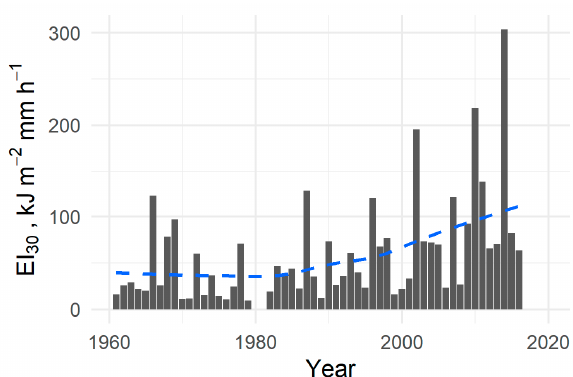
Figure 11. Annual variability of EI 30 between April and October at Müncheberg (near station 3376), smoothed with a local weighted regression (blue line). Values for 1980-81 missing. Original data resolution: 10 min.